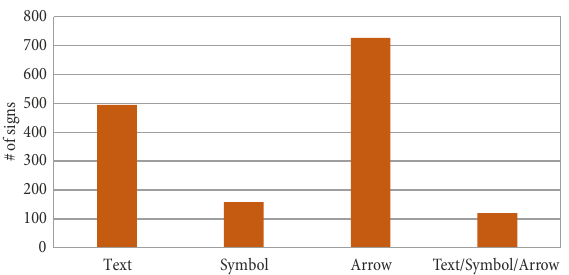
Fig. 4. Number of vandalized traffic signs by legend